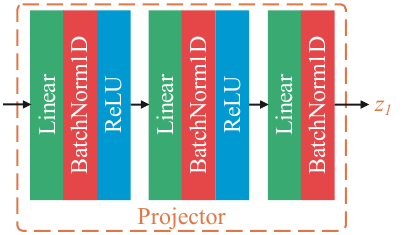
Figure 3. The architecture of the three-layer MLP projector.